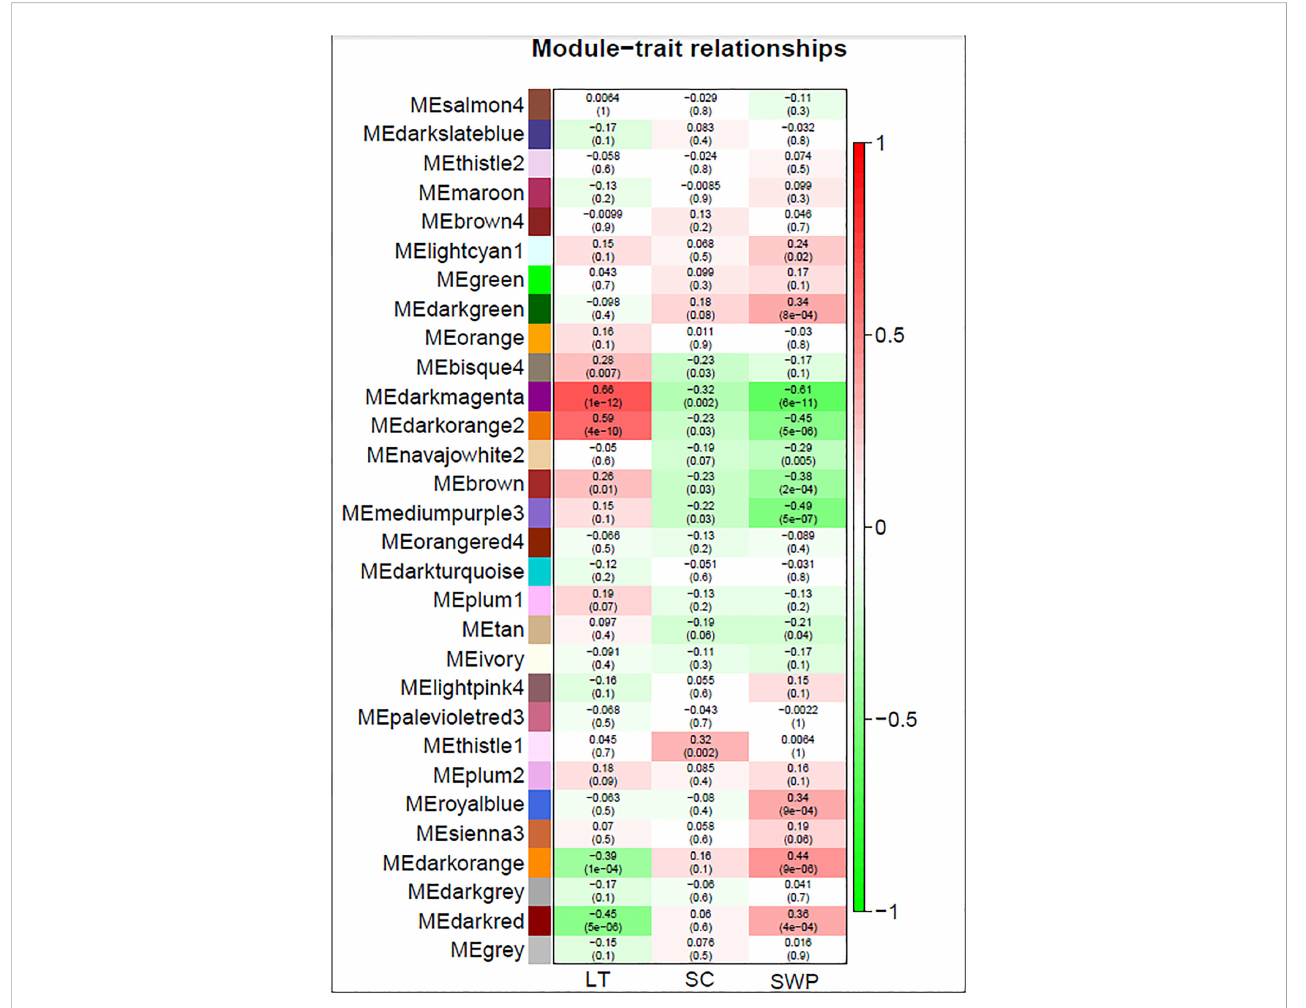
FIGURE 3 WGCNA module identi fi cation and correlation analysis of gene expression associated with leaf temperature, stomatal conductance to water vapor, and stem water potential in grapevine. Red and green color denote positive and negative correlations with gene expression, respectively. The top number in each cell indicates the correlation coef fi cient, and the bottom number indicates the correlation signi fi cance